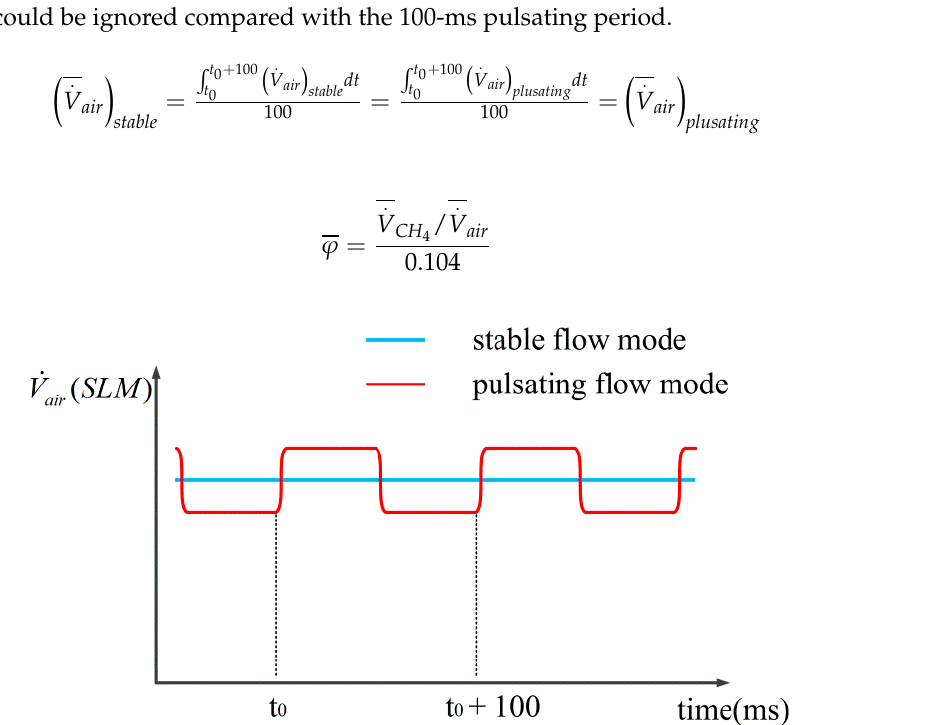
Figure 3. Air flow rates in different modes.